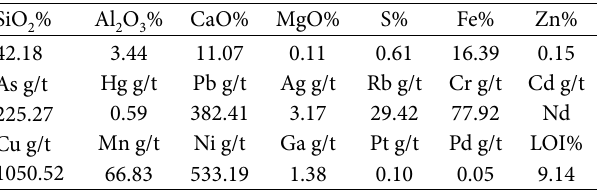
Table 1: Elemental analysis of fly